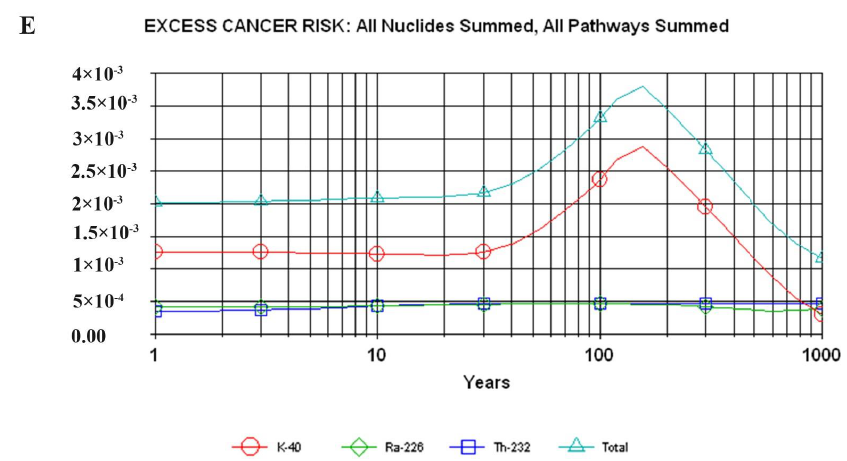
Figure 4. Cancer risk from all radionuclides. ( A ) Ajka coal, ( B ) Ajka red mud, ( C ) Almásfüzitő red mud, ( D ) Zalatárnok drilling mud, ( E ) Úrkút manganese. mud, ( D ) Zalat á rnok drilling mud, ( E ) Ú rk ú t manganese.